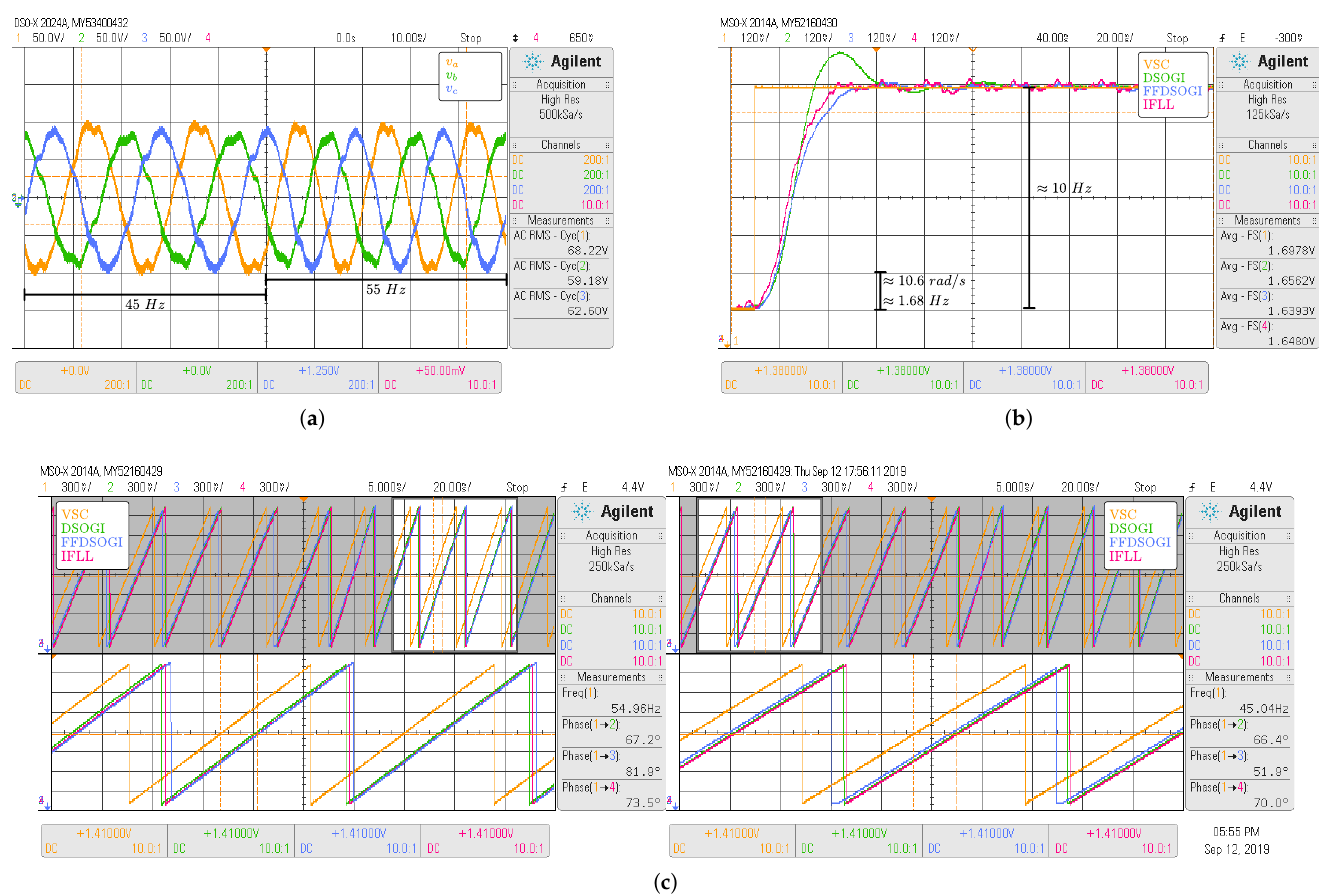
Figure 19. Experimental results for test #2 frequency step. ( a ) Measured voltages, ( b ) estimated frequency, and ( c ) estimated phase